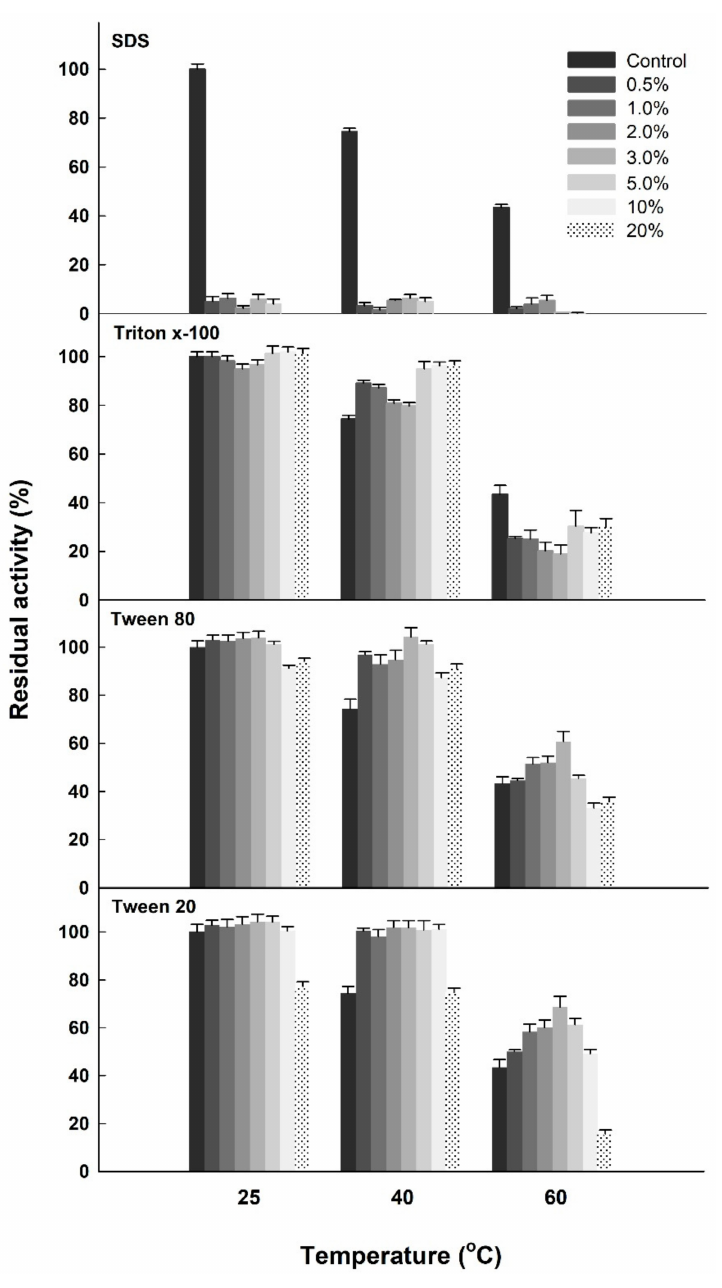
Figure 1. Effects of four different surfactants on the esterase activity of His 6 -tagged Bd PTE. The en- zyme samples were pre-incubated at the indicated temperatures for 1 h before activity assays. The esterase activity in the absence of surfactants was used as a control